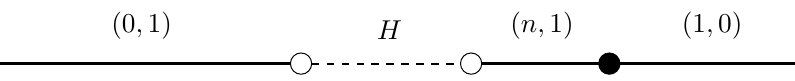
Figure 1 . Rod structure for a black lens with L ( n, 1) horizon